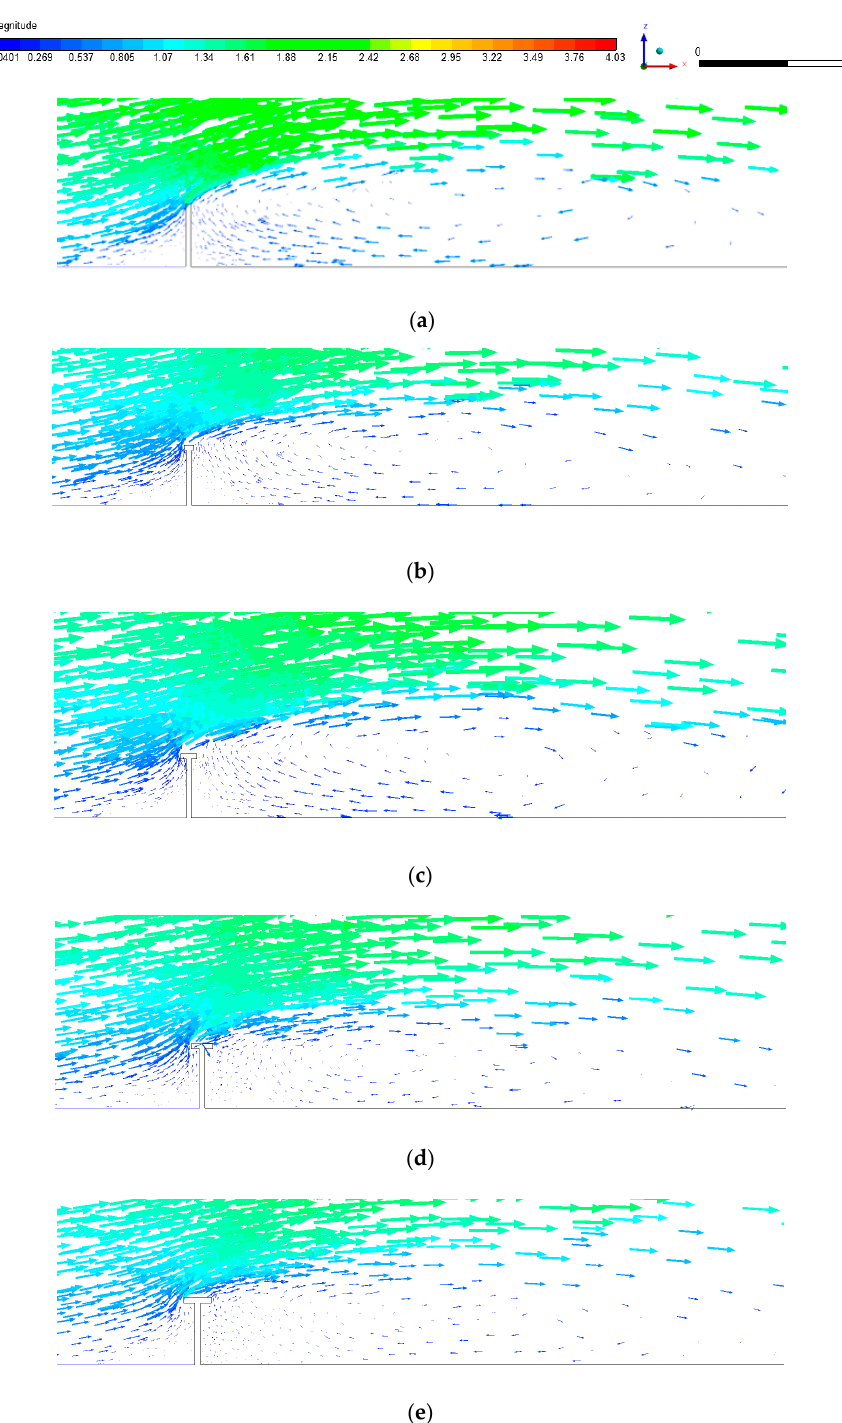
Figure 10. Wind velocity vector on the symmetry and on the cross section of the noise barrier. ( a ) Base case; ( b ) case 1; ( c ) case 2; ( d ) case 3; ( e ) case 4. case; ( b ) case 1; ( c ) case 2; ( d ) case 3; ( e ) case